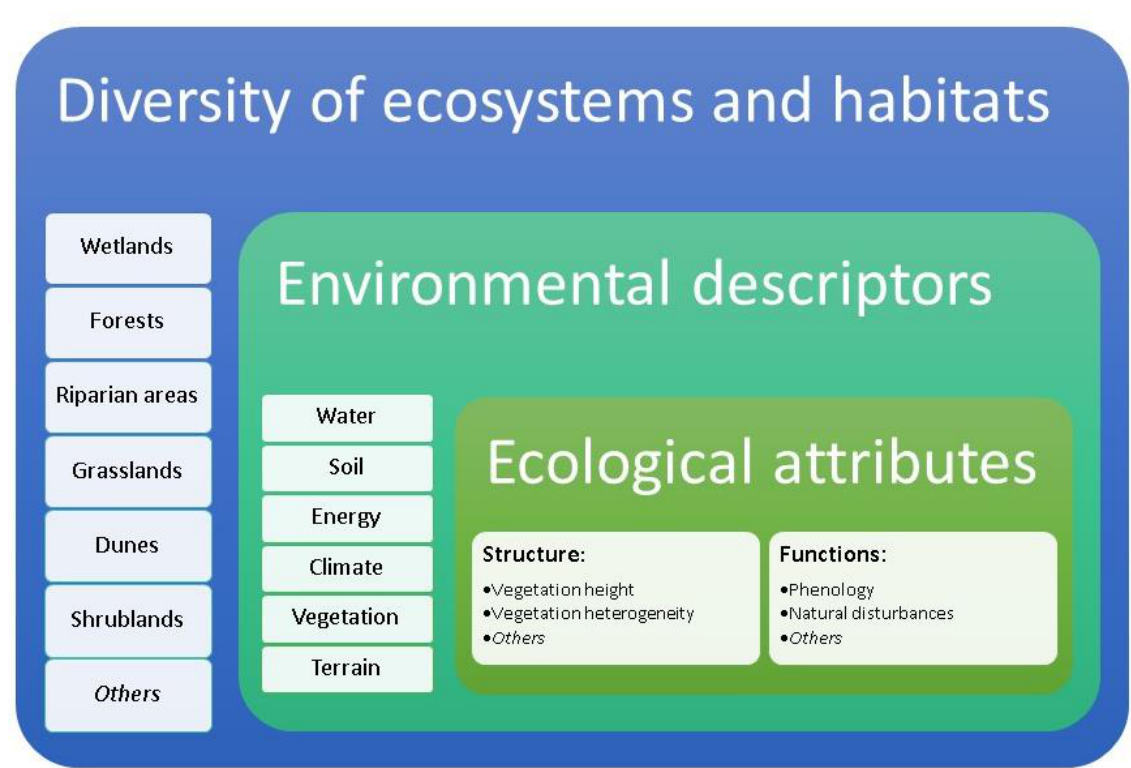
Figure 1. Overview of the different elements that need to be included and analyzed in the biophysical characterization of PAs.